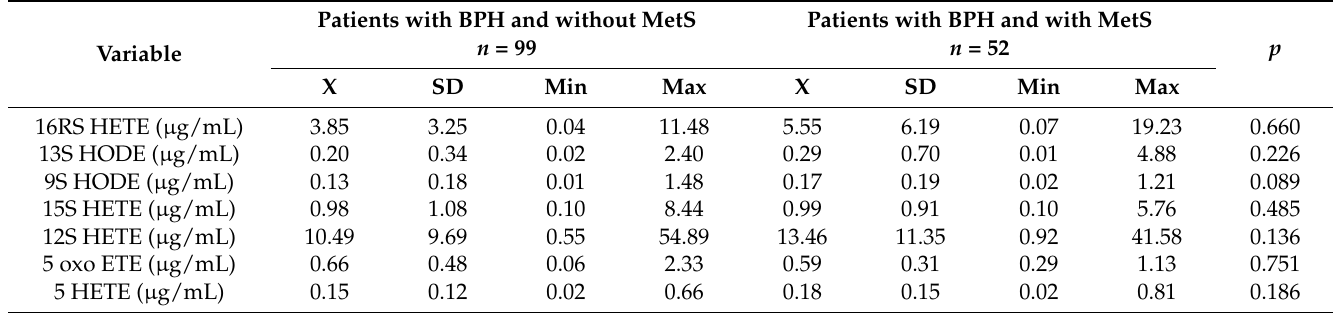
Table 1. The relationship between MetS and lipid mediators of inflammation in BPH patients.